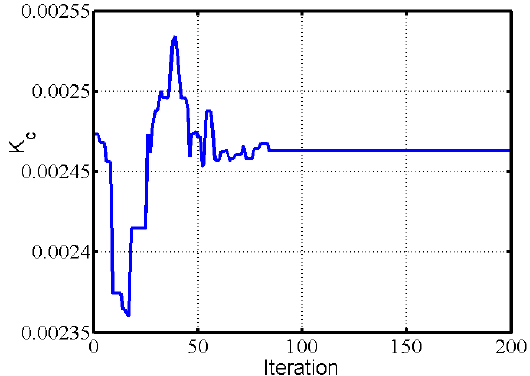
Figure 4. Evolutionary curve of the estimation of K c .